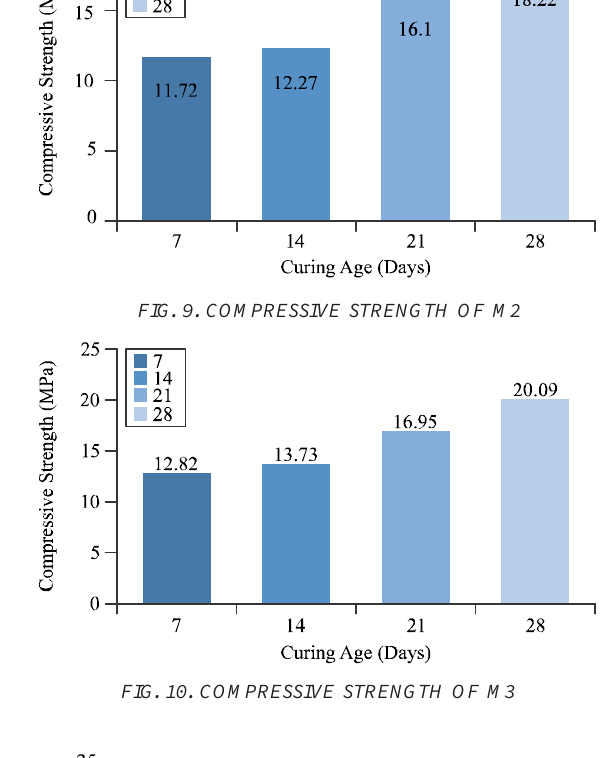
FIG. 10. COMPRESSIVE STRENGTH OF M3